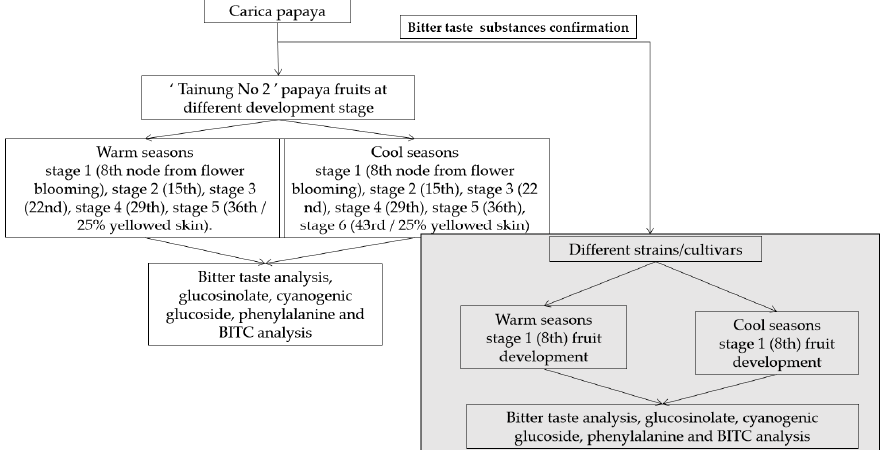
Figure A1. Graphical scheme of study approach.